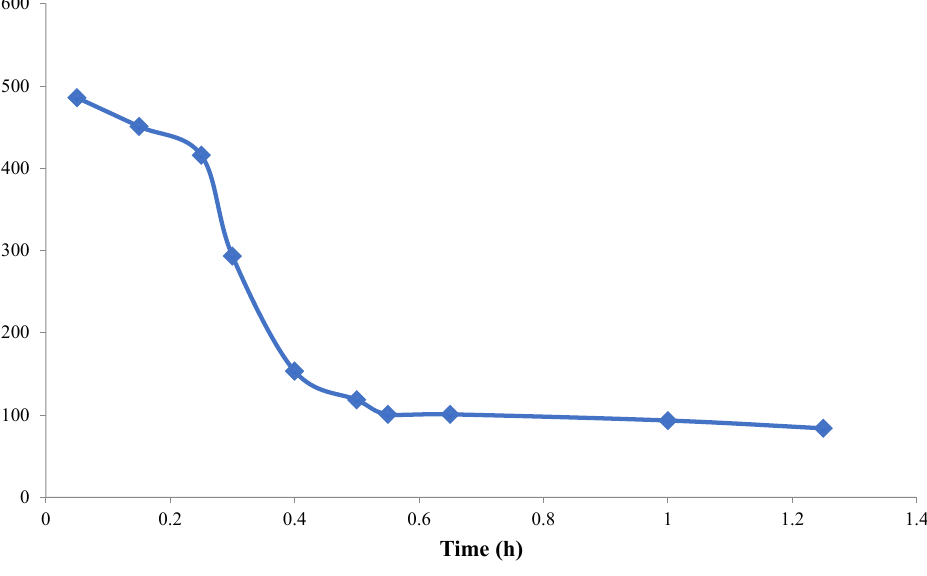
Fig. 11, Referring to the initial and final points of the curve, a great reduction in the flux is observed.